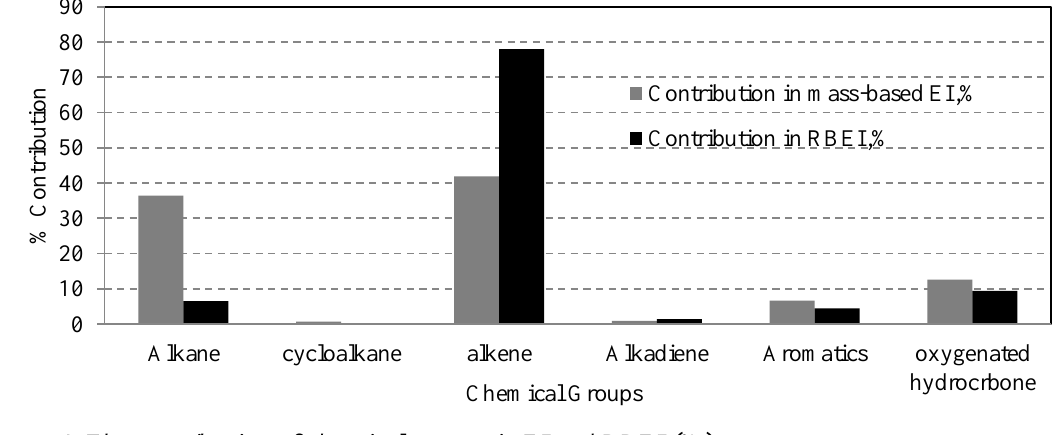
Figure 4. The contribution of chemical groups in EI and RBEI